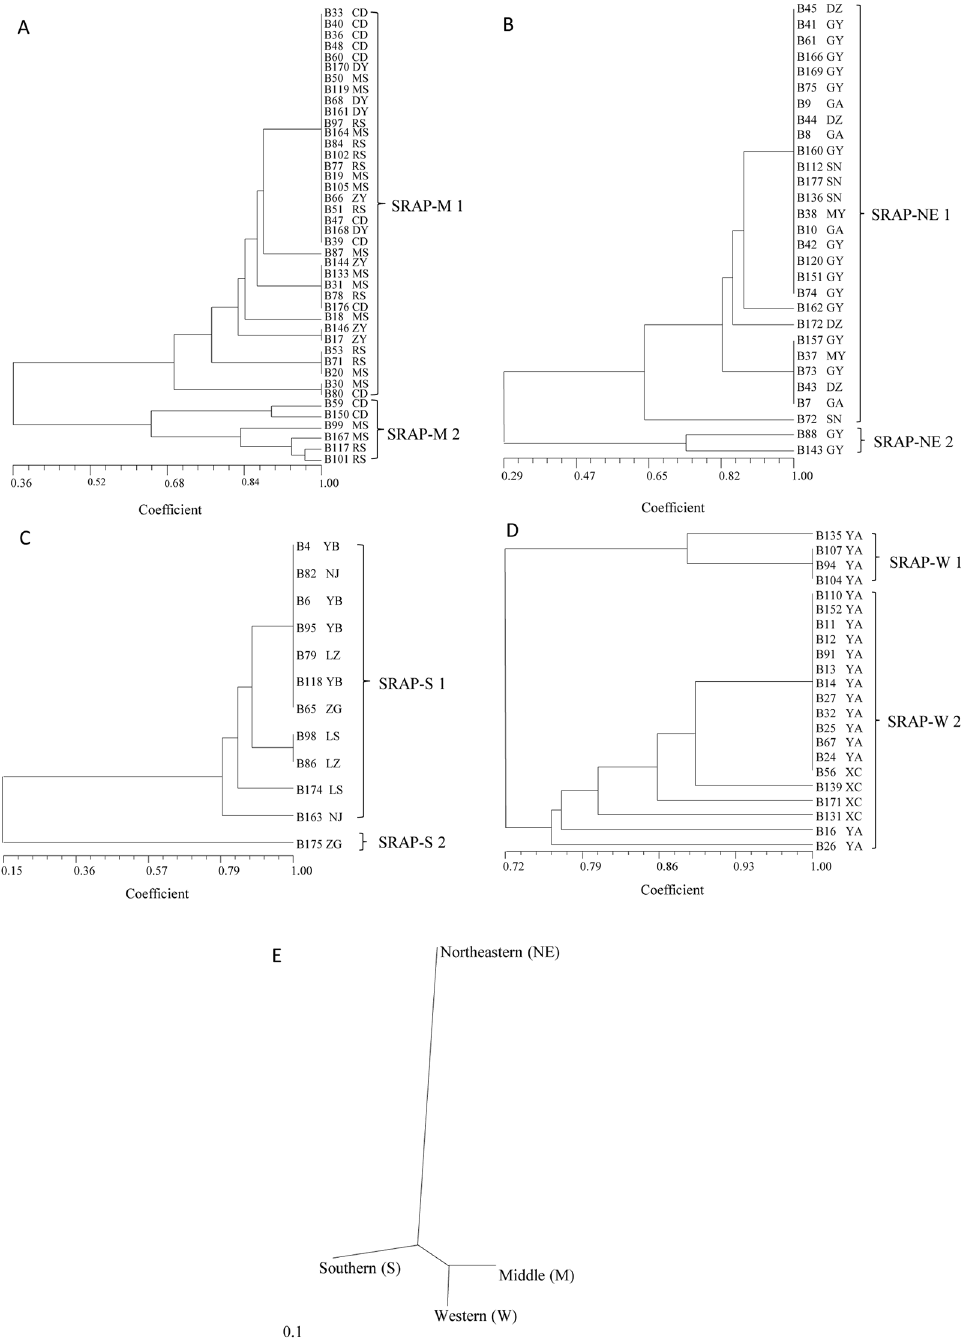
Fig 5. UPGMA dendrogram of Blumeria graminis f. sp. tritici strains based on the SRAP data showing relationships among strains isolated from the Middle region (A), Northeastern region (B), Southern region (C), Western region (D); Regional relationships (E) are also shown.